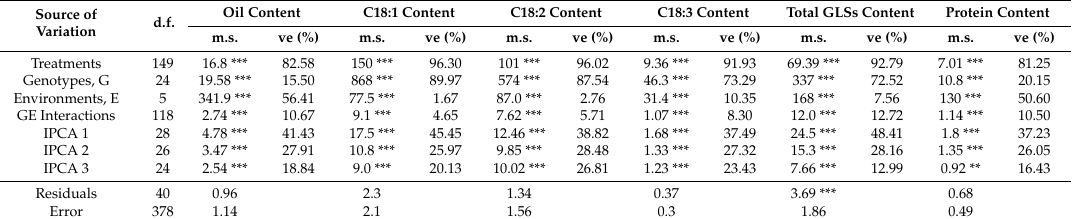
Table 3. Mean squares (m.s.) from analysis of variance of main e ff ects and interactions for tested traits in winter oilseed rape genotypes and variability explained (ve, in %).